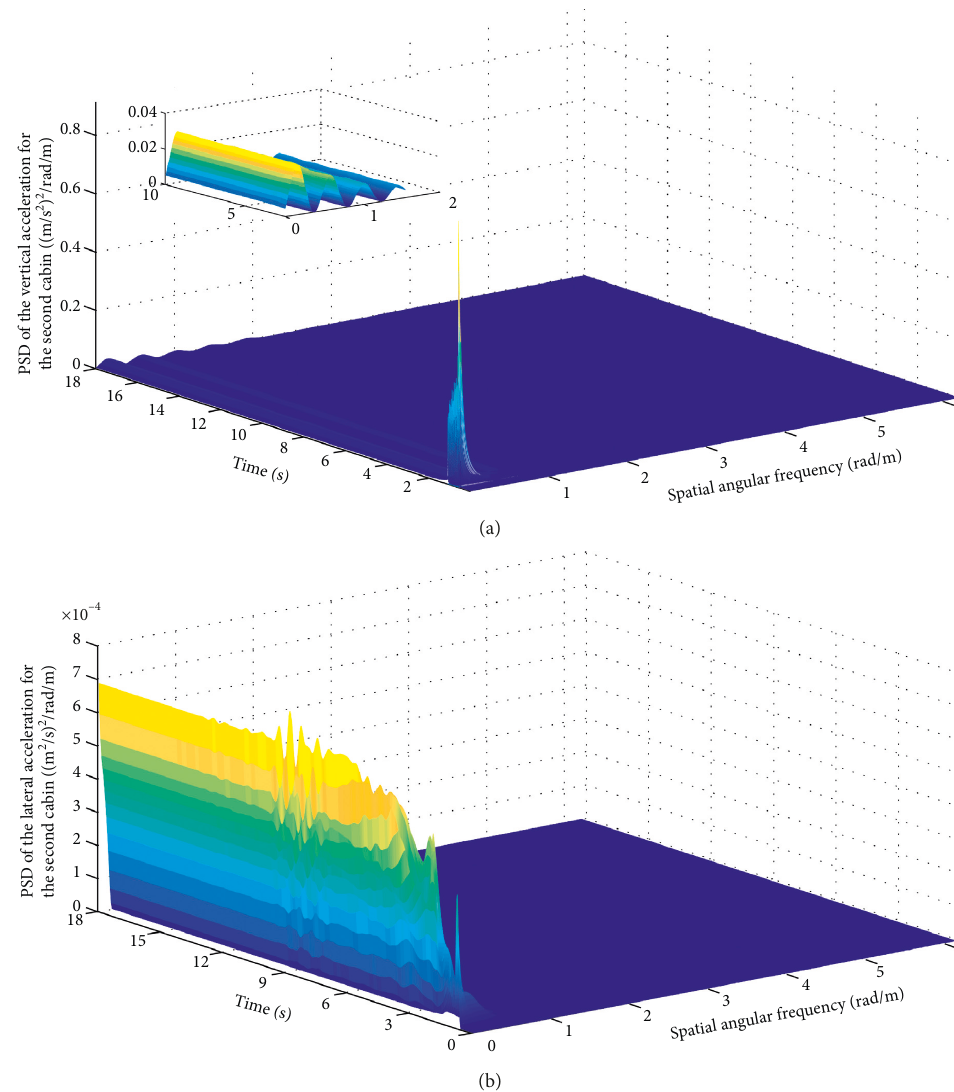
Figure 9: Time-dependent PSDs of the second cabin for (a) vertical and (b) lateral